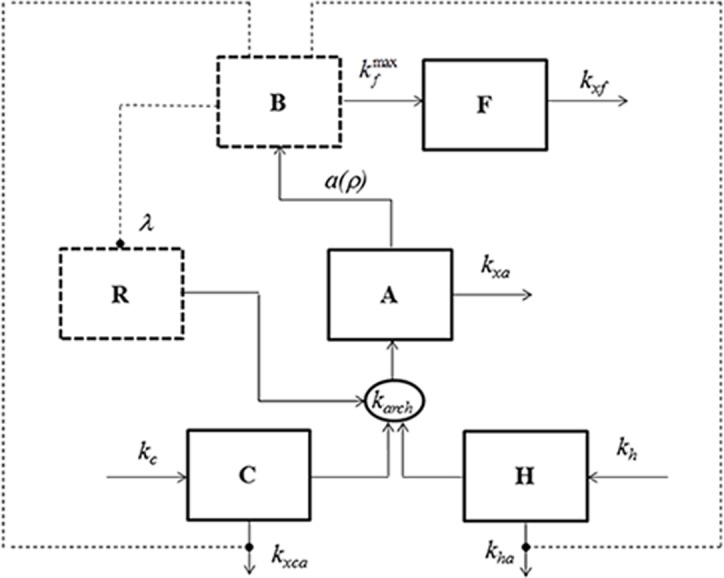
Block diagram of the ESDDeCAR-02 model.Blocks in continuous lines represent the model state variables; blocks in dashed lines represent the two defined algebraic variables.